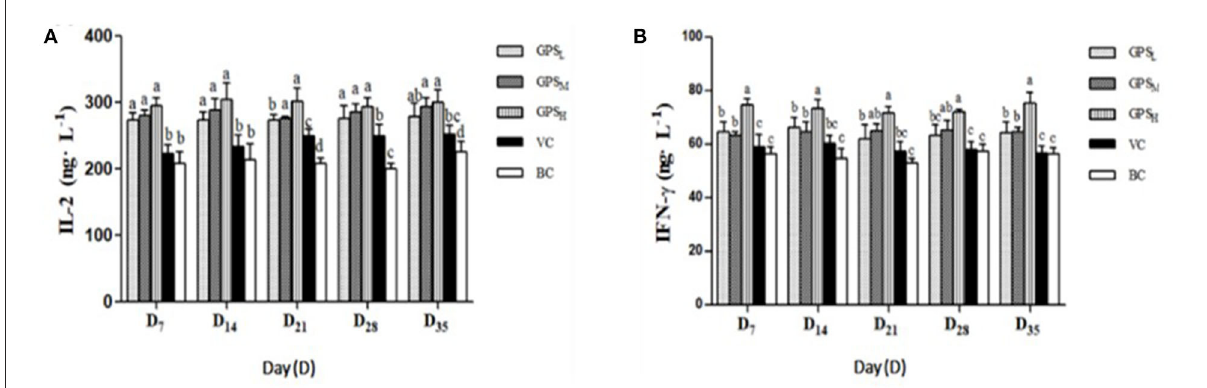
FIGURE8 The changes of IL-2 (A) and (B) IFN- γ concentrations in each group (ng · L − 1 ). a − d Values in the histogram with different letters indicate significant